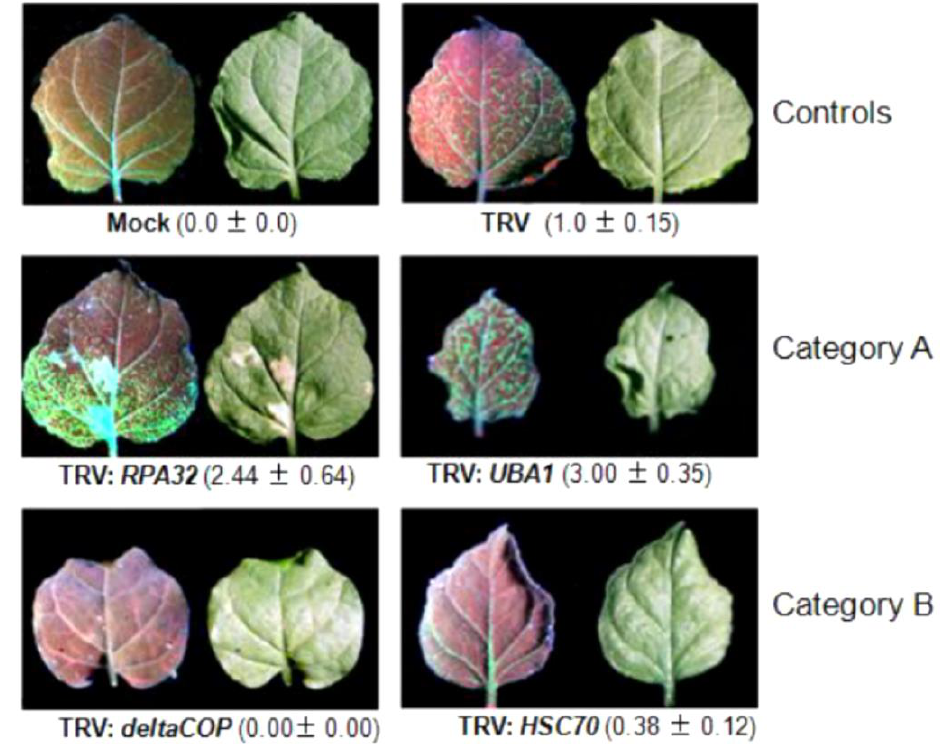
Figure 2. Screening of candidate genes in 2IRGFP transgenic N. benthamiana plants. Plants were co-inoculated with a TRV: Gene construct and TYLCSV. GFP expression was monitored daily up to 15 days post-inoculation (dpi). The picture shows GFP expression in one of the apical leaves under UV (left) and visible light (right) of 2IRGFP N. benthamiana transgenic plants 15 days after they were co-infected with TYLCSV and TRV constructs to induced silencing of genes classified in category A (Replication associated protein A, RPA32 , and Ubiquitin activating enzyme 1, UBA1 ) or category B (Coatomer delta subunit, deltaCOP, and Heat shock cognate 70, HSC70 ). Leaves from control 2IRGFP plants are shown: agroinfiltrated with an empty binary vector (Mock) or with the empty TRV vector (TRV). The relative amount of TYLCSV DNA accumulated in co-infected plants was quantified by qPCR; results are shown below the images. Values are the mean of five to ten plants. The numbers correspond to the mean ±standard error. This experiment was repeated three times with similar